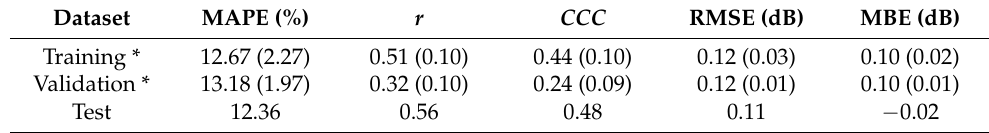
Table 5. Multi-speaker intensity model performance on training, validation, and test